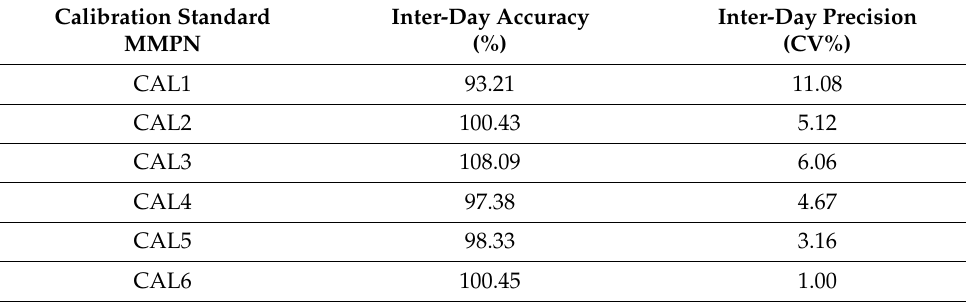
Table 5. Inter-day accuracy and precision (CV%) referred to CALs of